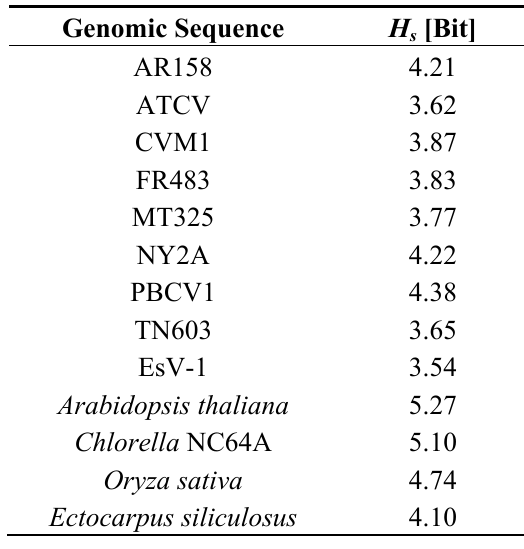
Table 1. Superinformation values H for various genomic sequences. Note the tendency of s for organisms in comparison to viruses. increased H s